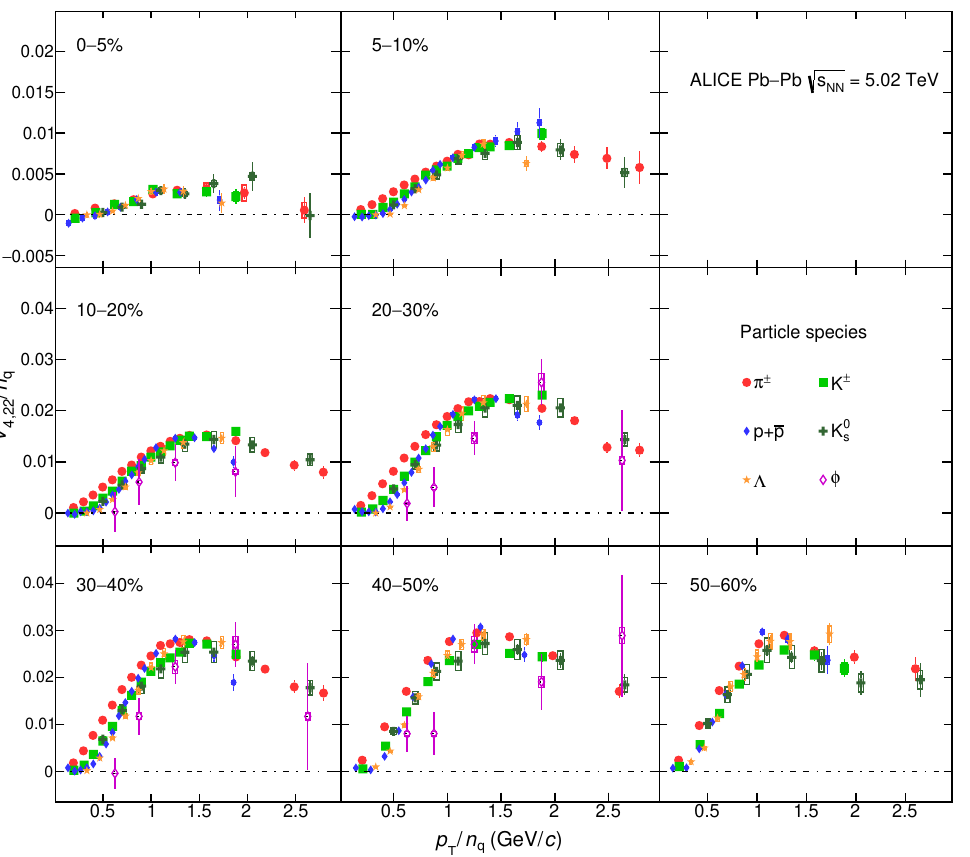
Figure 10 . The p T =n q -dependence of v 4 ; 22 =n q for di(cid:11)erent particle species grouped into di(cid:11)erent p centrality intervals of Pb-Pb collisions at s NN = 5 : 02 TeV. Statistical and systematic uncertainties are shown as bars and boxes,